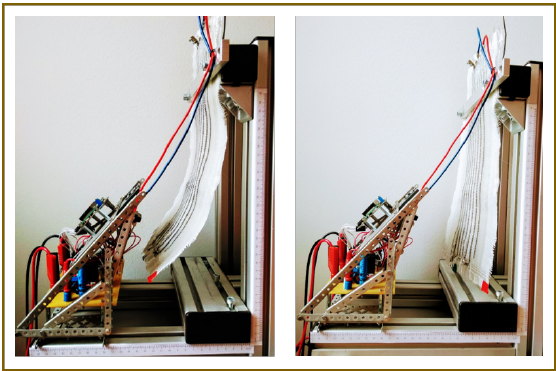
Figure 2. Deflection of the textile-reinforced composite with side view of the test bench unit.